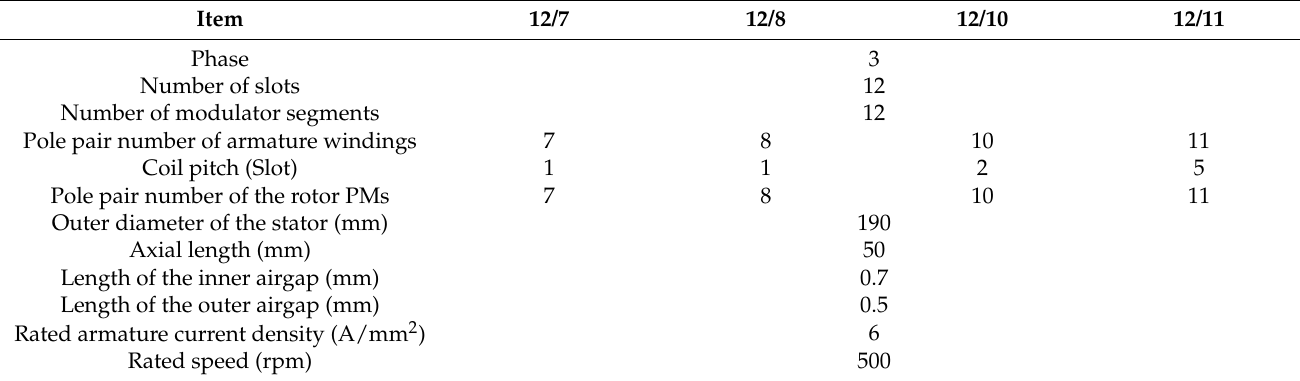
Table 2. The common design parameters of the optimized models.